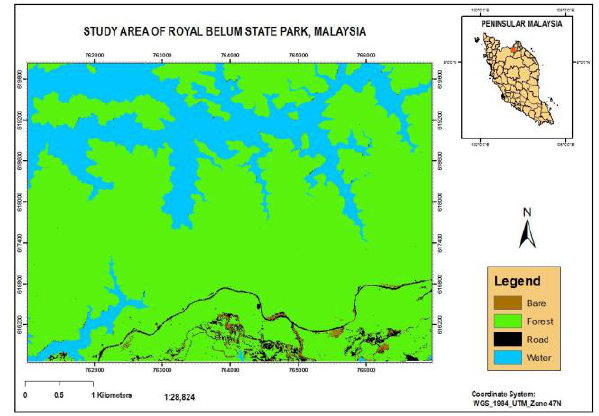
Figure 1. Map showing location of the study area (inset, location in Malaysia)